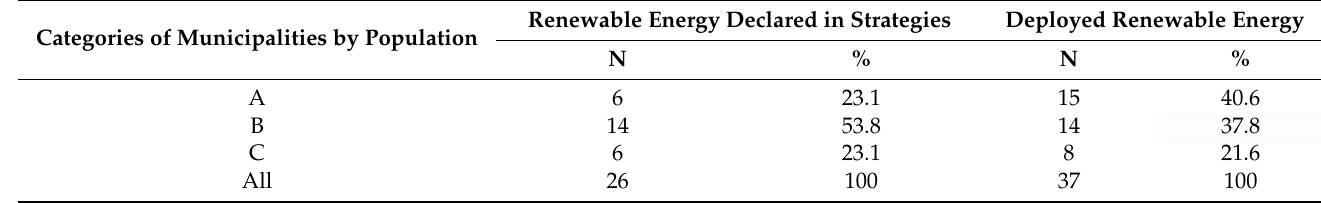
Table 5. Renewable energy declared in the strategies versus practical activities in particular types of Cittaslow